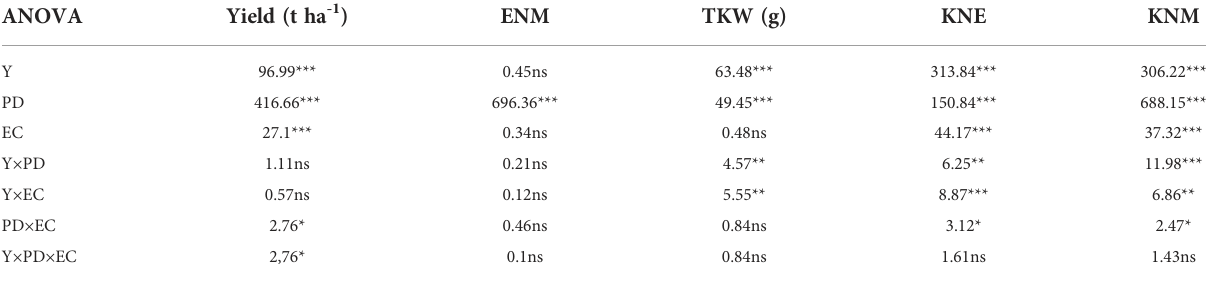
TABLE 3 Results of ANOVA on the effects of year (Y), plant density (PD), EC treatments (EC) and their interactions on maize yield, ENM, TKW, KNE and KNM in 2020 – 2021. ANOVA